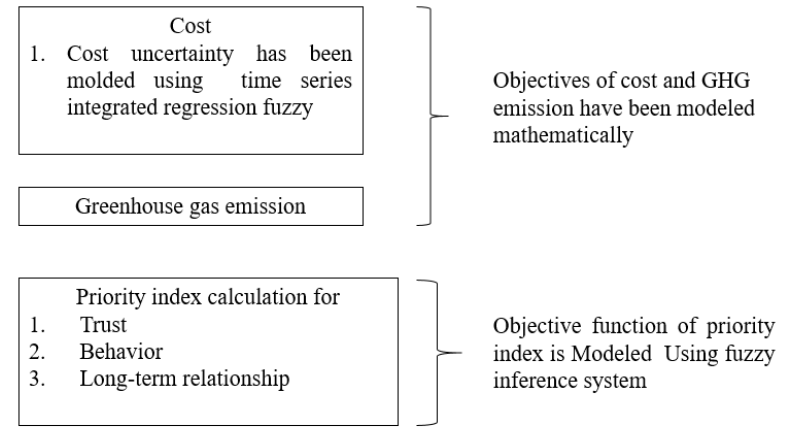
Figure 1. Procedure for objective function development.